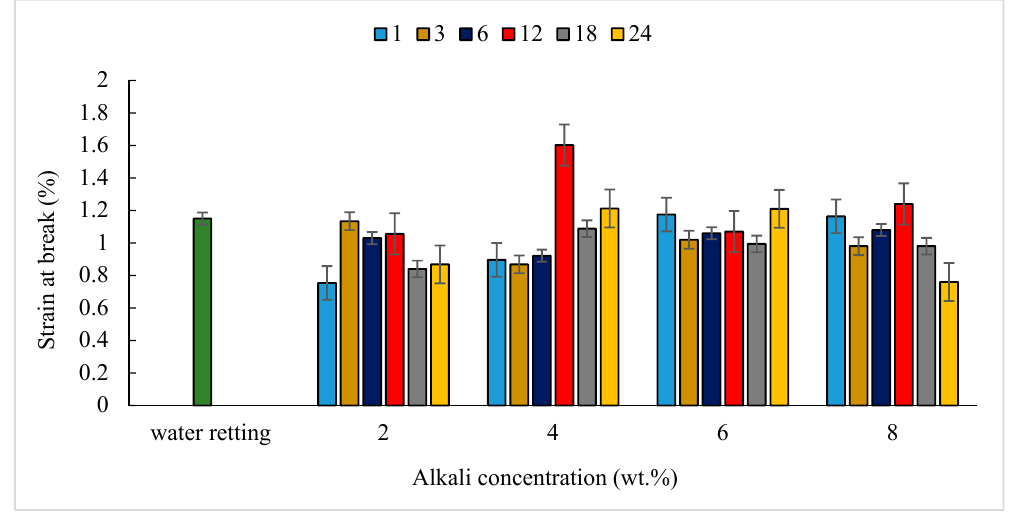
Figure 9. Strain-at-break of single-cellulosic bamboo-fiber strips subjected to water retting and different alkali concentrations, for various soaking times.